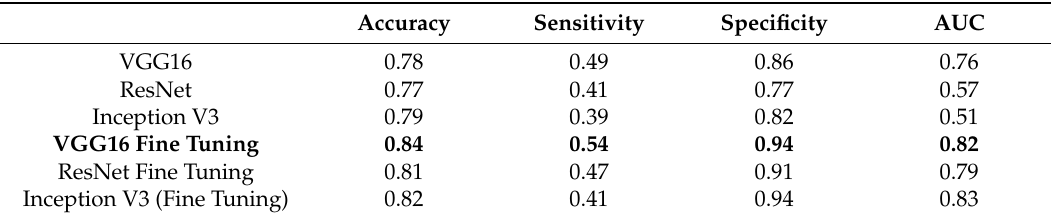
Table 4. Performance: Results of condyle abnormality.